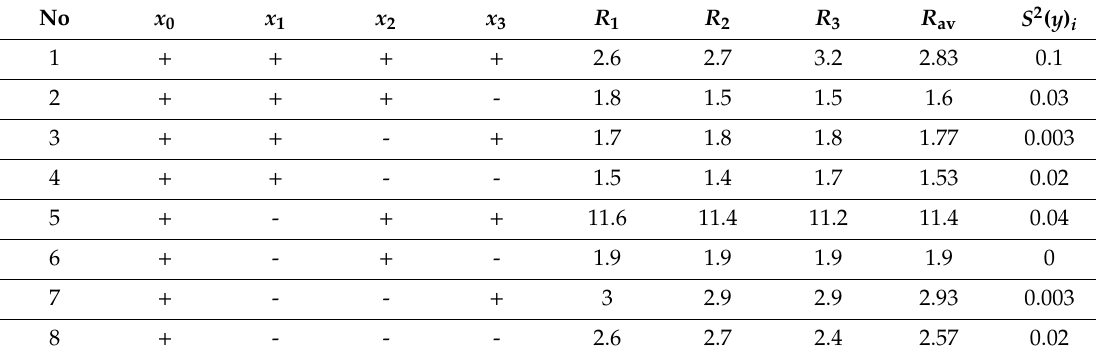
Table 3. Matrix of the experimental plan for power in the range 4–6